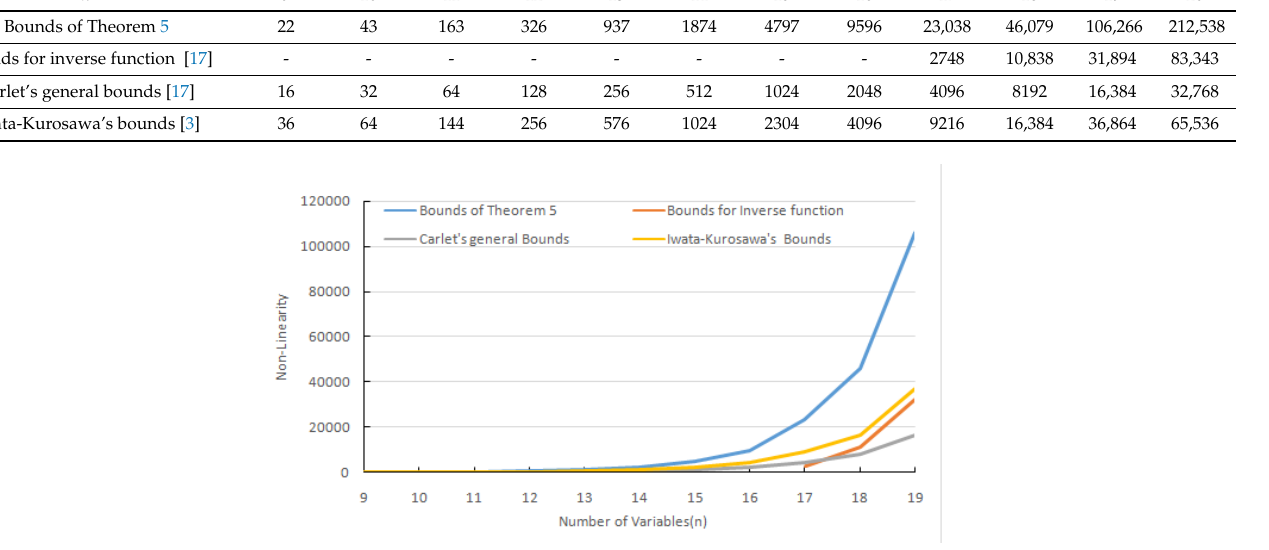
Figure 3. Bounds obtained in Theorem 5,